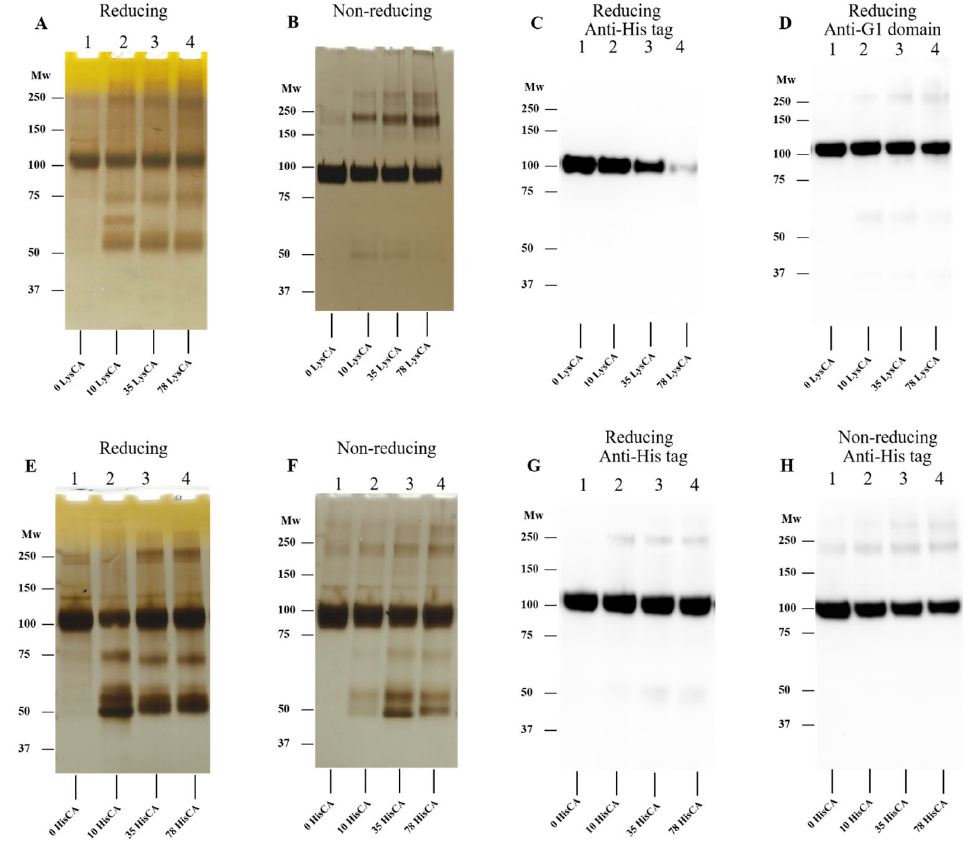
Figure 7. Effects of Lys-CA (panels A – D ) and His-CA (panels E – H ) on rhAggrecan. Preformed chloramines (see Section 2) were incubated with rhAggrecan (643 nM) in buffer A for 24 h at 37 ◦ C before examination by SDS-PAGE with subsequent silver staining (panels A , C – E , G , reducing gels, panel B , F , H , nonreducing conditions), or immunoblotting by using an anti-His-tag antibody (panel C , G , H ) or an anti-G1 domain antibody (panels D ). For further details, see Section 2 and the legend to Figure 3. Representative images are presented from three independent experiments. Molecular mass markers are indicated to the left of each image.